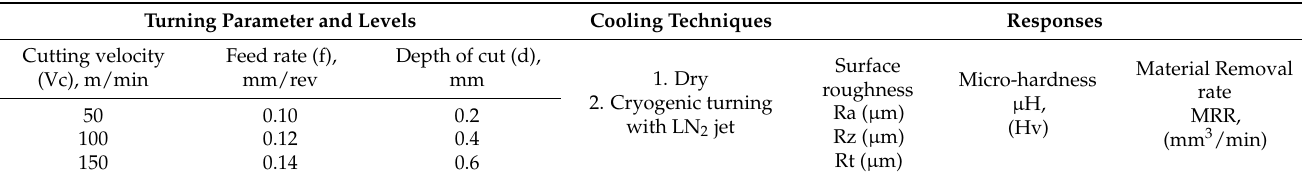
Table 3. Turning parameters, cooling techniques and response parameters.